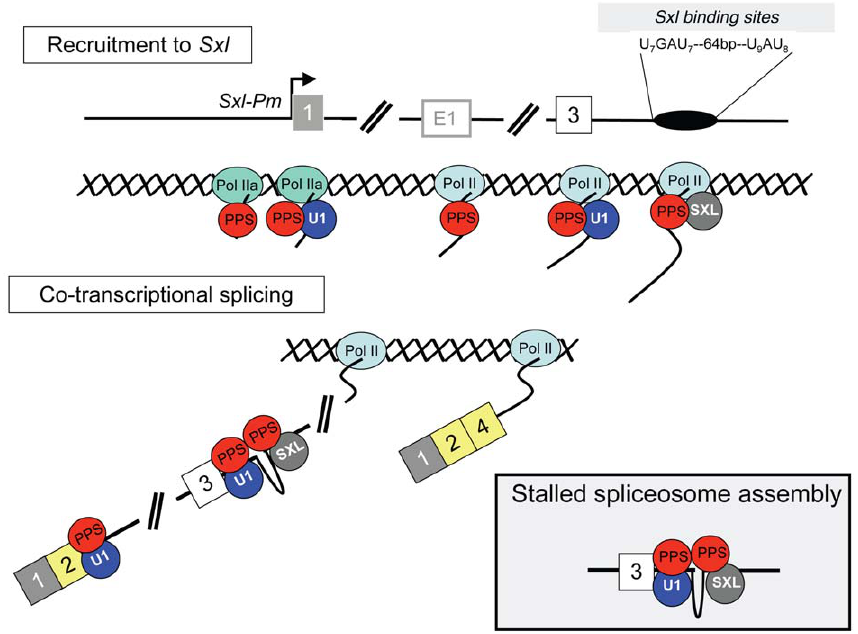
Figure 9. Co-transcriptional model for Sxl splicing autoregulation. PPS associates with Pol II during transcription (Pol II, oval) to help recruit the U1 snRNP (U1, blue circle) and SXL (grey circle) to the appropriate locations on the nascent transcript. In addition, PPS may help nucleate the interaction between the U1 snRNP and SXL. Splicing could be blocked immediately (insert) or spliceosome assembly could continue, stalling only later in the pathway. The end result is a dead-end complex that guarantees that the male exon will be skipped, and that exon 2 is spliced to exon 4. In males, where there is no SXL protein, the U1 snRNP is free to assemble into a functional spliceosome and exon 3 is included in the mature transcript (not